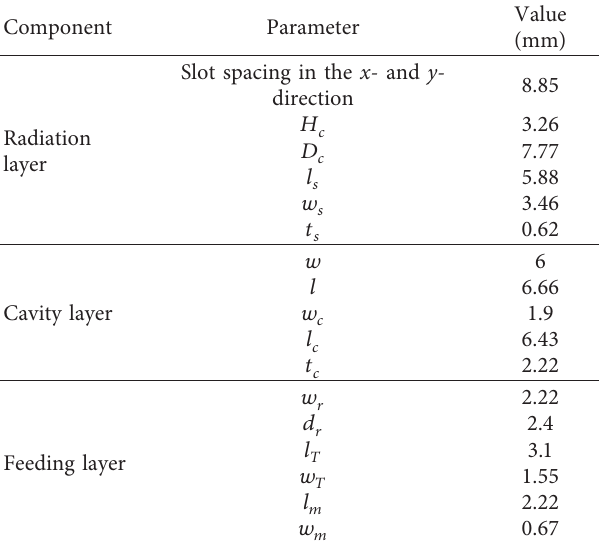
Table 1: Dimensions of the 2 × 2 cavity-backed slot subarray.